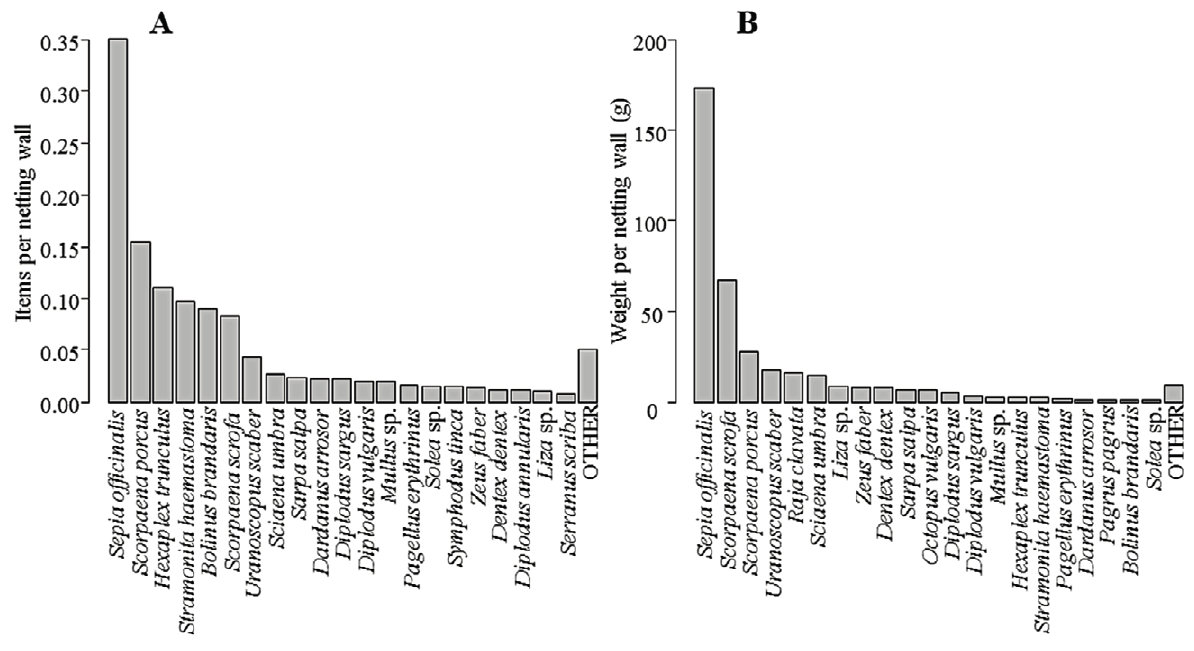
Fig. 2. – Abundance and biomass of commercial species in the surveyed trammel nets estimated as number of items per netting wall (A) and weight (in g) per netting wall